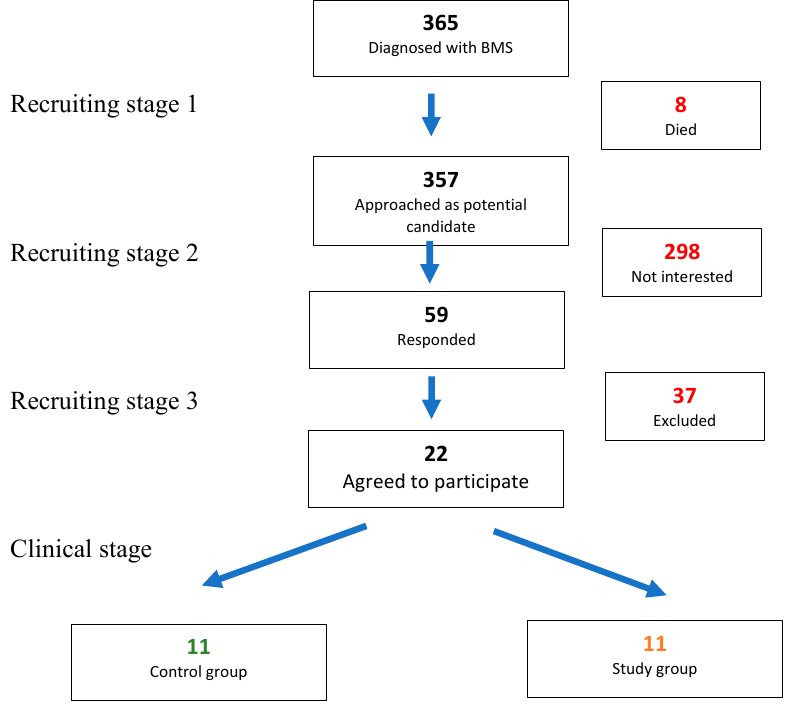
Figure 1. Patient recruitment procedure.